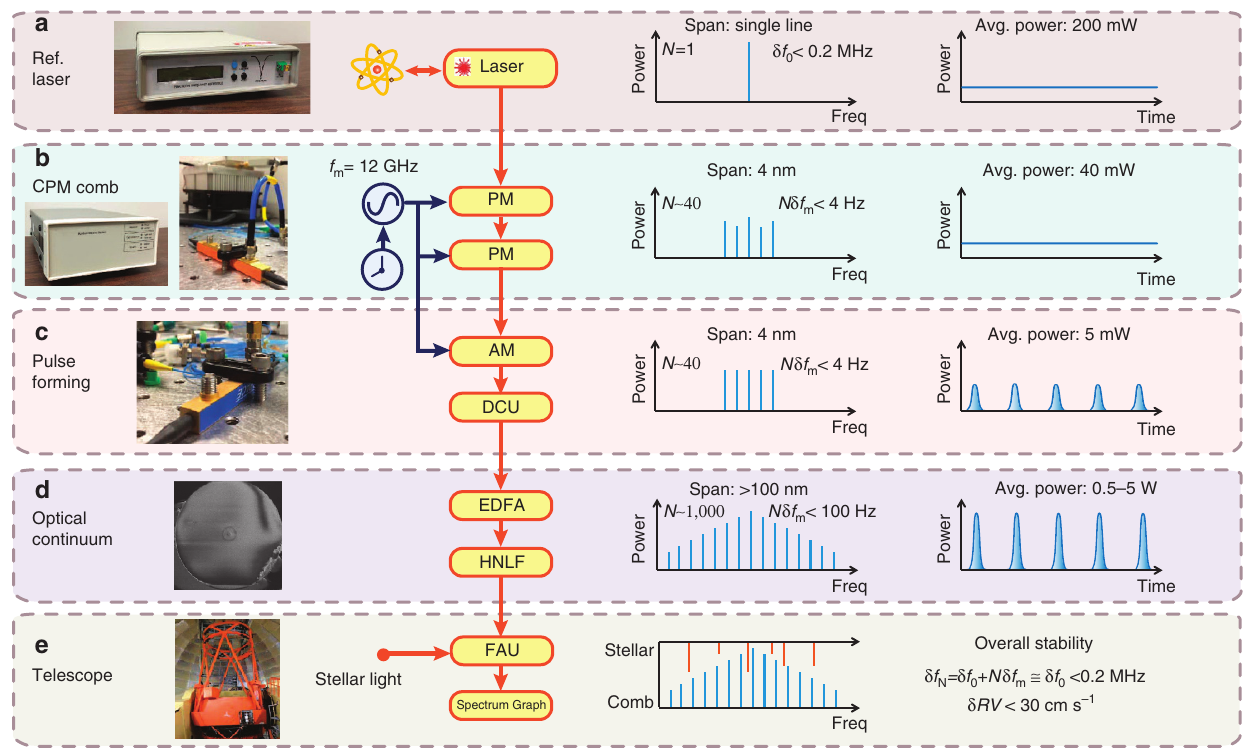
Figure 1 | Conceptual schematics of the line-referenced electro-optical frequency comb for astronomy. Vertically, the first column contains images of key instruments. ( a – e ) The images are reference laser, Rb clock (left) and phase modulator (right), amplitude modulator, highly nonlinear fibre and telescope. A simplified schematic set-up is in the second column. Third and fourth columns present the comb state in the frequency and temporal domains. The frequency of N -th comb tooth is expressed as f N ¼ f 0 þ N (cid:3) f m , where f 0 and f m are the reference laser frequency and modulation frequency, respectively. N is the number of comb lines relative to the reference laser (taken as comb line N ¼ 0), RV is radial velocity and d f N , d f 0 and d f m are the variance of f N , f 0 and f m . ( a ) The reference laser is locked to a molecular transition, acquiring stability of 0.2MHz, corresponding to 30cms (cid:2) 1 RV . ( b ) Cascaded phase modulation (CPM) comb: the phase of the reference laser is modulated by two phase modulators (PM), creating several tens of sidebands with spacing equal to the modulation frequency. The RF frequency generator is referenced to a Rb clock, providing stability at the sub-Hz level ( d f m o 0.03Hz at 100s). ( c ) Pulse forming is then performed by an amplitude modulator (AM) and dispersion compensation unit (DCU), which could be a long single mode fibre (SMF) or chirped fibre Bragg grating (FBG). ( d ) After amplification by an erbium-doped fibre amplifier (EDFA), the pulse undergoes optical continuum broadening in a highly nonlinear fibre (HNLF), extending its bandwidth 4 100nm. ( e ) Finally the comb light is combined with stellar light using a fibre acquisition unit (FAU) and is sent into the telescope spectrograph. The overall comb stability is primarily determined by the pump